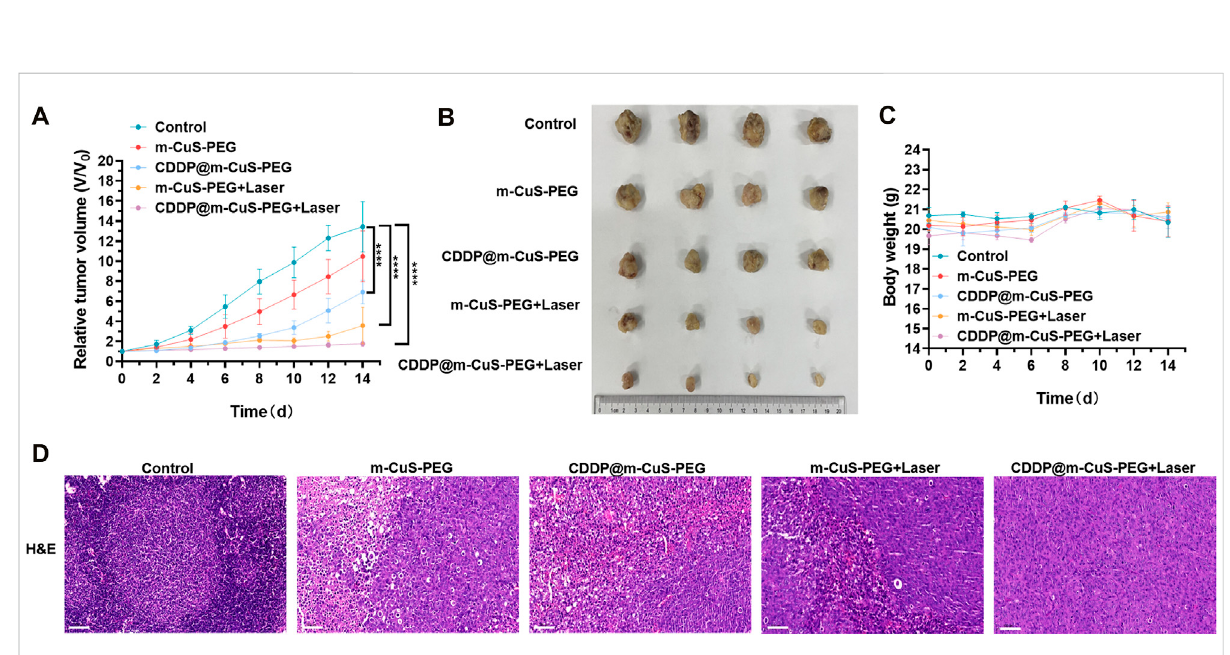
FIGURE 6 In vivo antitumor ef fi cacy of CDDP@m-CuS-PEG on metastasized breast cancer therapy. (A) Tumor volumes relative to the start point in each groupcollectedonday14,samplesize: n =4. (B) Imagesoftumor-bearingmiceondays2,4,6,8,10,12and14. (C) Weightchangescurvewithin14- day treatments of each group, sample size: n = 4; (D) H&E staining of tumor sections in each group. Scale bars = 100 μ m for